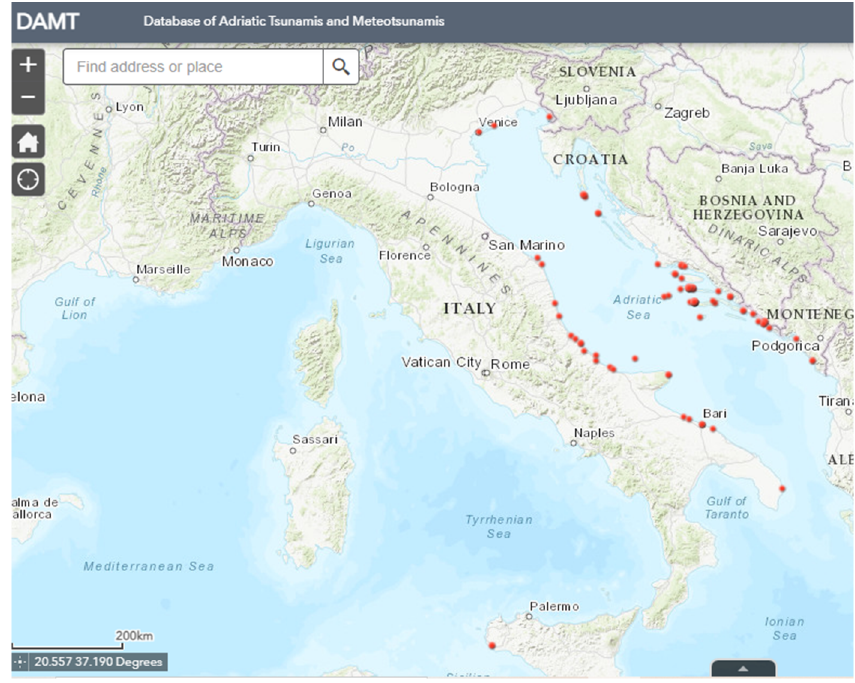
Figure 5. Geographical distribution of the meteotsunami effects.